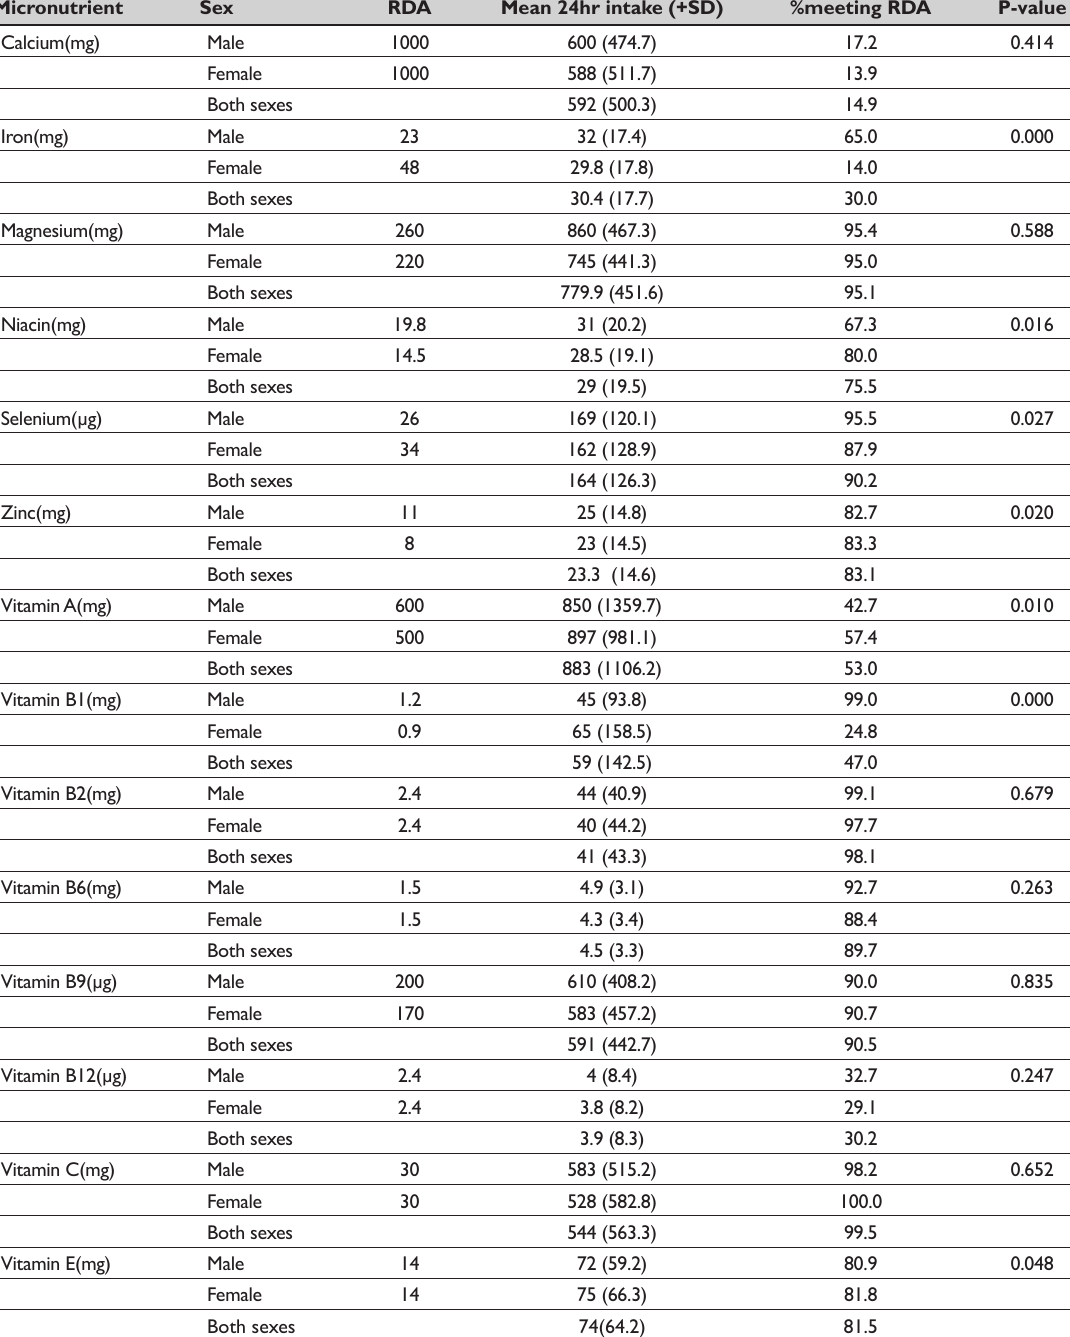
Table 1: Adequacy of micronutrient intake among HIV seropositive patients by sex specific RDA